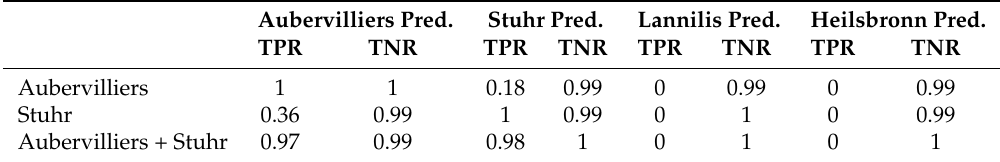
Table 4. OSMWatchman prediction results.